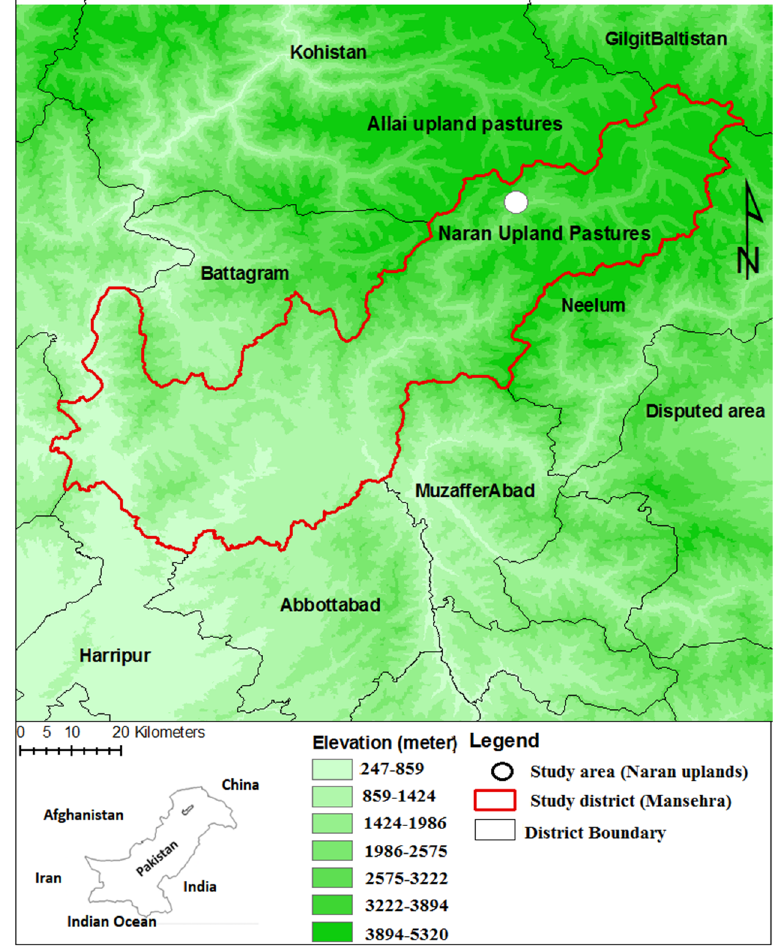
Figure 1. Map of the study area (Naran uplands)